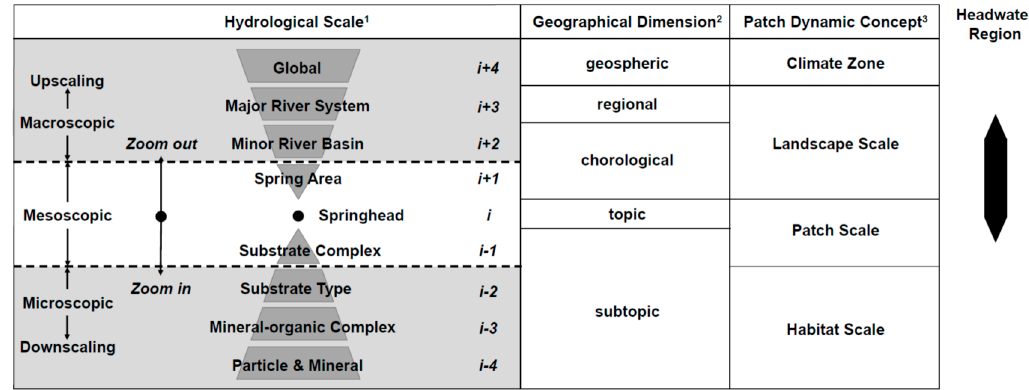
Figure 4. A hierarchical framework of the Springscape within the Critical Zone concept for bridging multiple scales from a micro- to a macroscopic level (inspired by [35], basic idea see [27]). Superscripts refer to 1: [28]; 2: [90]; 3: [76]. Headwater regions mainly belong to minor river basins, spring areas, and springheads, as part of major river basins there connect to the regional scale and vice versa, while springheads are the source of headwater streams connected to the subtopic scale ( right ).